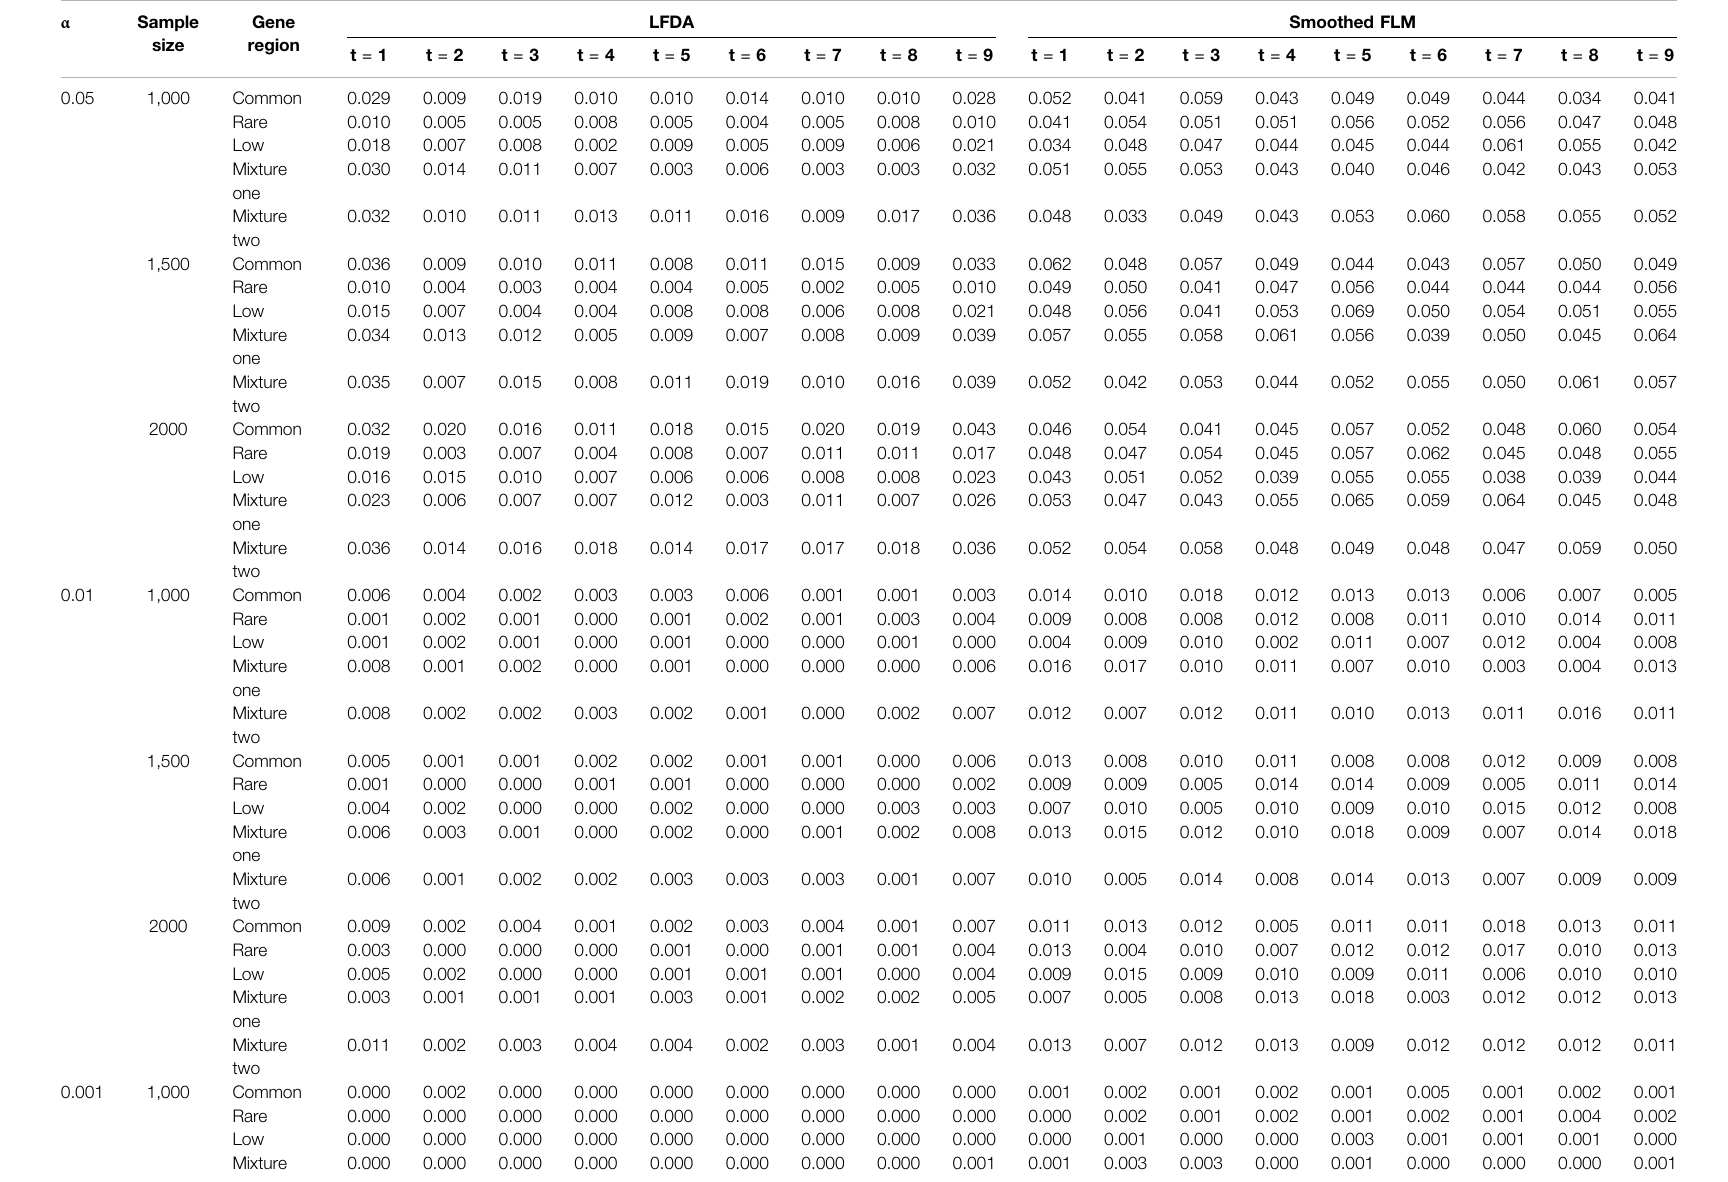
TABLE 4 | Type Ⅰ error rates of LFDA and Smoothed FLM based on 1,000 simulated replicates for linkage disequilibrium